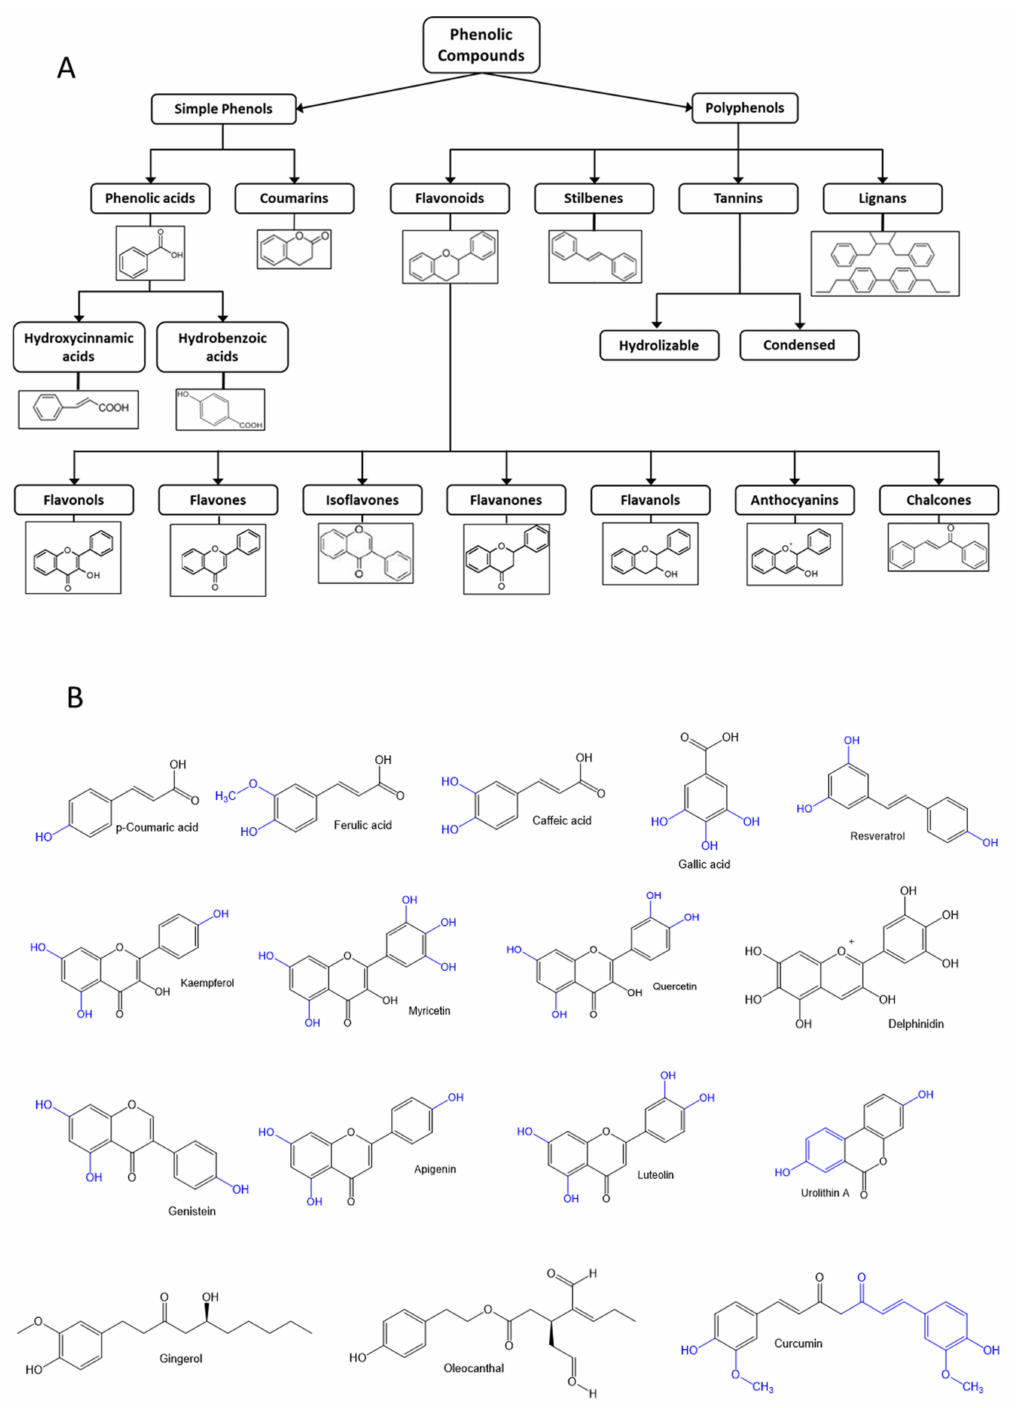
Figure 3. ( A ) Classification of phenolic compounds. ( B ) Chemical structure of the polyphenols found in the components of anti-inflammatory